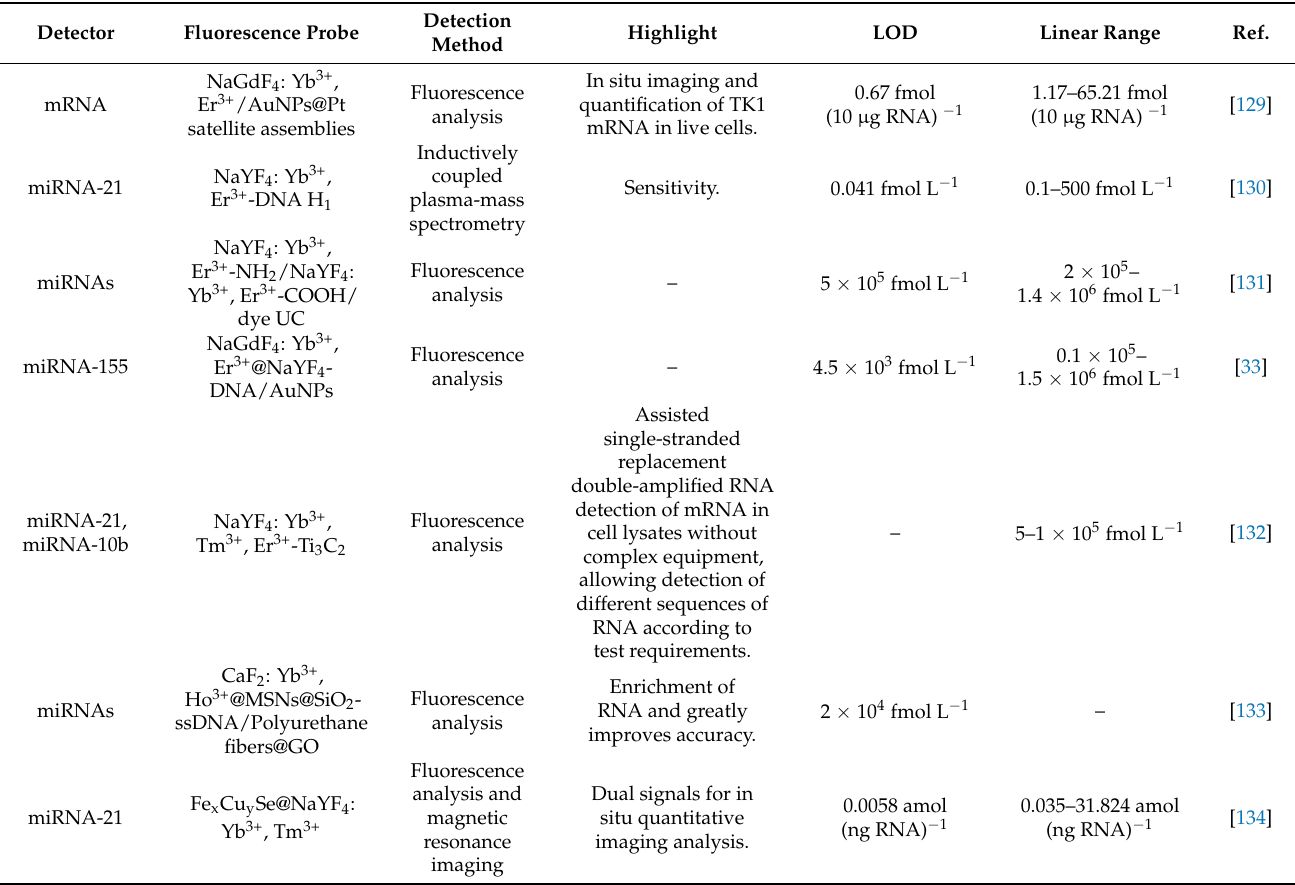
Table 4. Summary of experimental results for miRNA